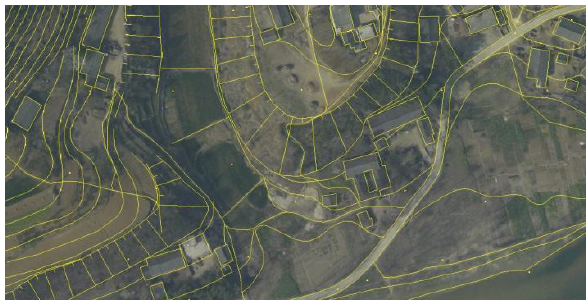
Figure 6. result of DLG and